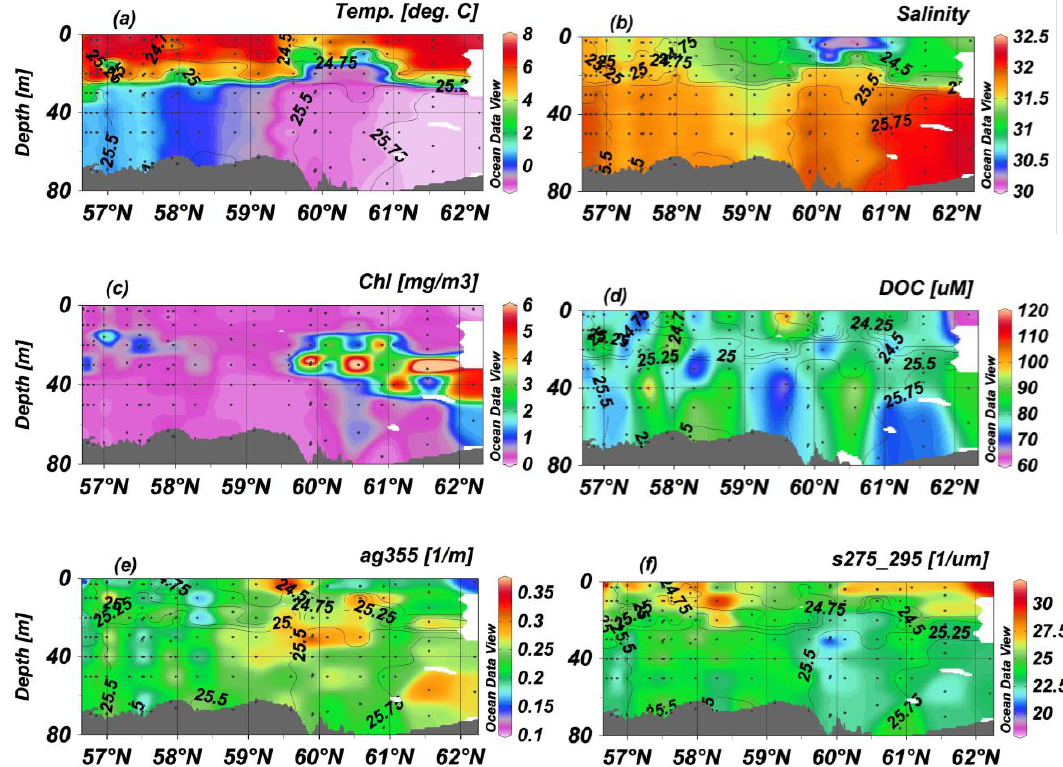
Figure 6. Vertical section of (a) temperature, (b) salinity, (c) Chl, (d) DOC, (e) a g 355, and (f) S 275 − 295 along 70m transect with overlain contour lines of